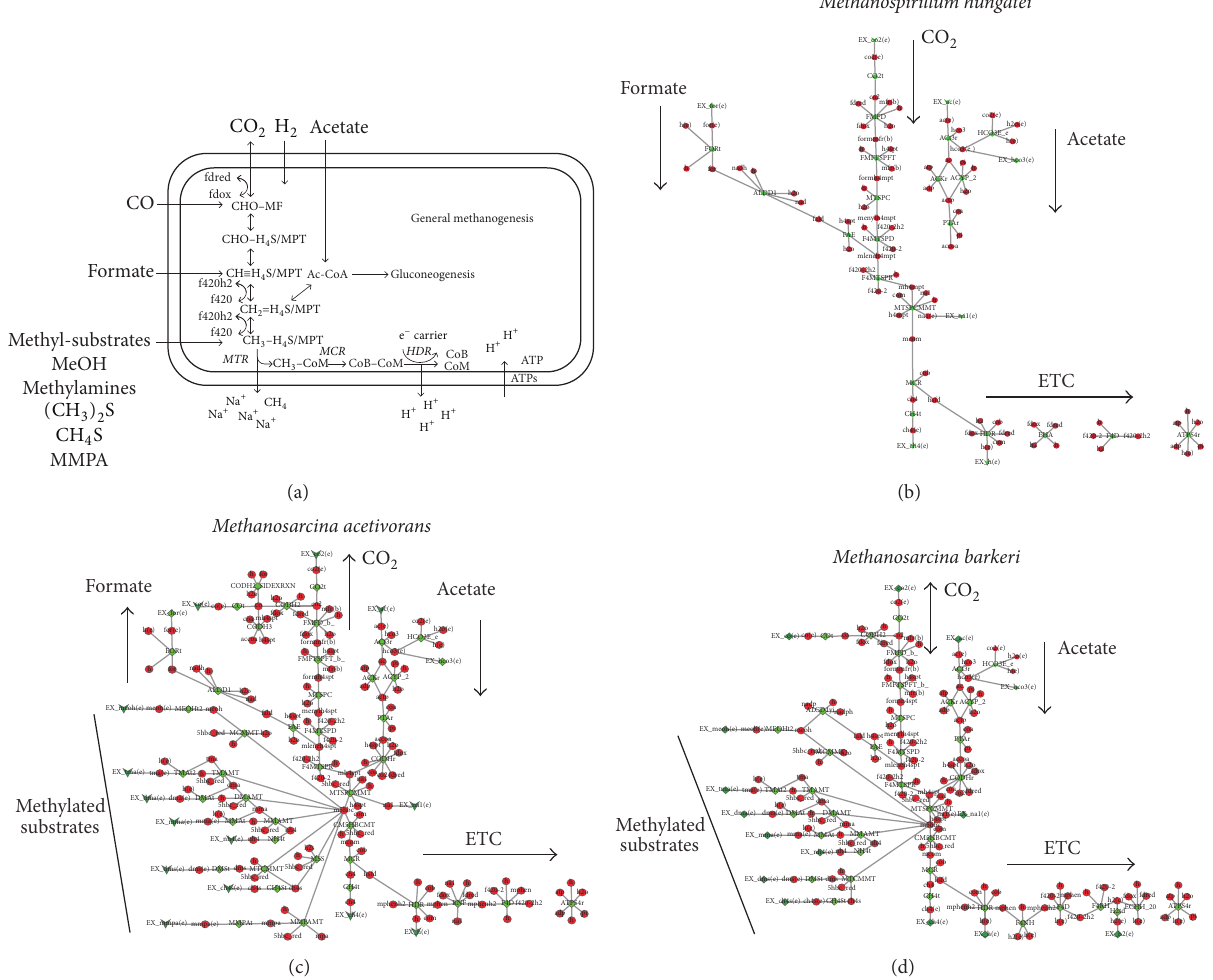
Figure 3: Methanogenesis pathway framework. (a) The basic structure of methanogenesis showing where the major growth substrates across all methanogens enter the pathway. The simplest methanogens are only capable of growing on CO 2 /H 2 and/or formate while the most complex methanogens are also capable of methylotrophic and acetotrophic growth. H 4 S/MPT stands for tetrahydrosarcinapterin (H 4 SPT) and tetrahydromethanopterin (H 4 MPT). The former is found exclusively in Methanosarcinales whereas the latter is found in all other methanogens. (b) The hypothesized methanogenesis pathways for M. hungatei ( i Mhu428) [21]. Although it cannot use acetate as an energy source, the pathway to take up acetate is still present to shuttle it into gluconeogenesis. (c) The hypothesized methanogenesis pathway for M. acetivorans ( i ST807) [29]. The conventional CO 2 reduction pathway is only run in reverse as this methanogen cannot metabolize CO 2 . (d) The hypothesized methanogenesis pathway for M. barkeri ( i AF692) [19] which bears great resemblance to that of M. acetivorans . The major differences between the two organisms’ methanogenesis pathways lie in the electron transport chain (ETC). The specific pathways for each methanogen follow the same topological structure as the general methanogenesis illustration. Red circles are metabolites while green diamonds signify enzymatic reactions of the pathway.